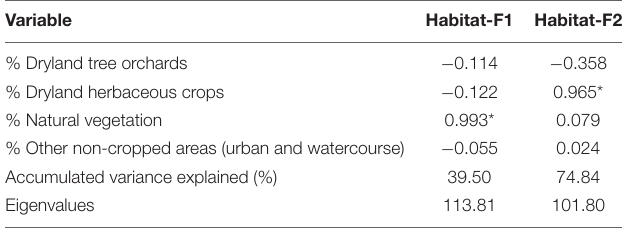
TABLE 3 | Results of the principal component analysis (PCA) carried out to synthesize variation in habitat composition within transects.